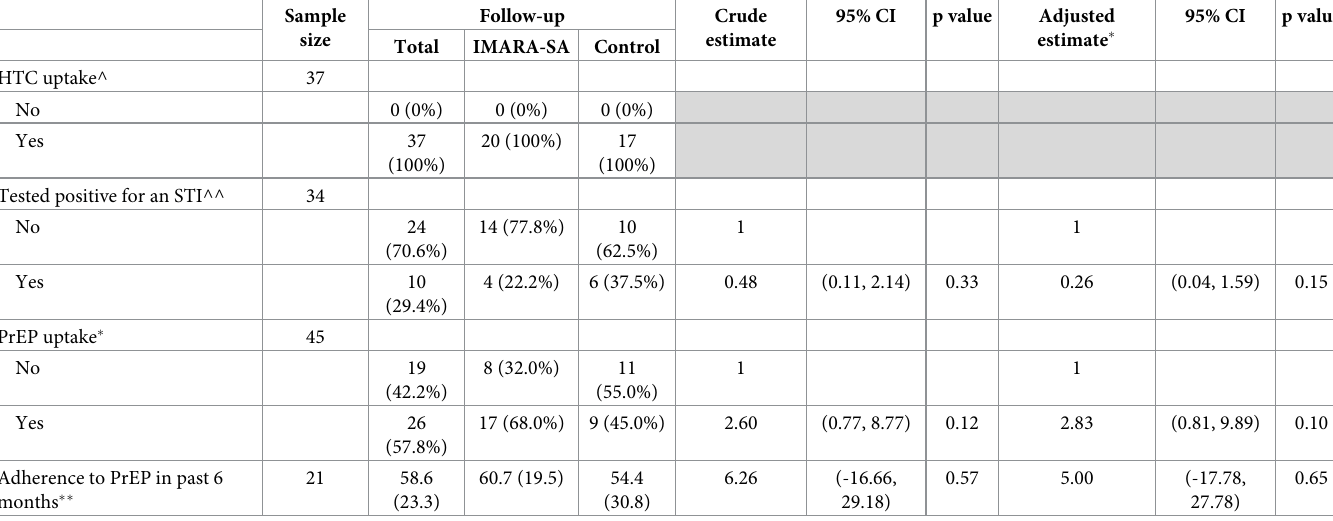
Table 2. Differences in HIV testing and counseling (HTC), STI test results, and PrEP outcomes between treatment groups at